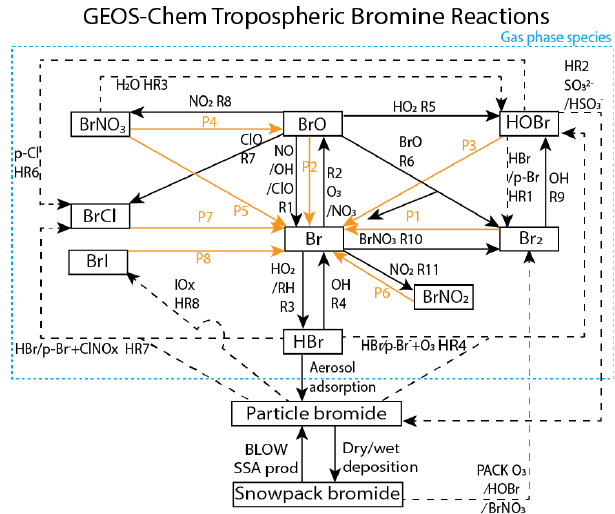
Figure 1. GEOS-Chem tropospheric bromine reactions. Tropo- spheric bromide reservoirs are shown in black boxes, with attached lines indicating reactions. Solid black lines R1–R11 indicate gas- phase chemical reactions, solid orange lines P1–P8 indicate photol- ysis reactions, and dashed black lines HR1–HR8 indicate heteroge- neous reactions. All gaseous species may undergo dry deposition. Additional sources of tropospheric bromine include the production of particulate bromide by the BLOW mechanisms and the produc- tion of Br 2 by the PACK mechanism as well as the degradation of organobromines to form Br (OR1). Table 3 enumerates the specific species involved in each equation and shows the reaction rates for each respective